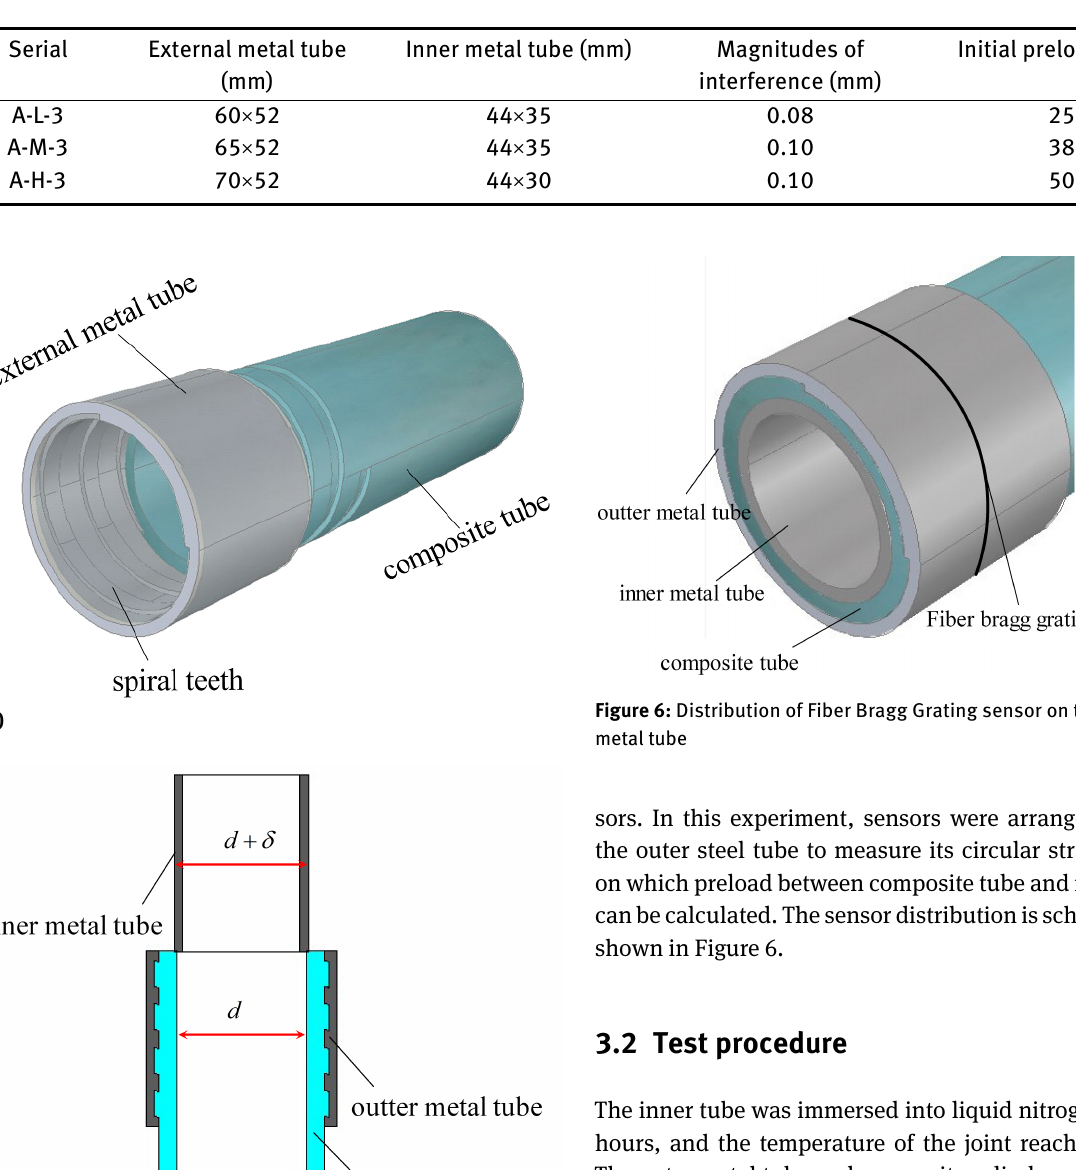
mens under the corresponding magnitudes of interference at room temperature. As observed in the table, three initial preloads of 25 MPa, 38 MPa, and 50 MPa were designed.